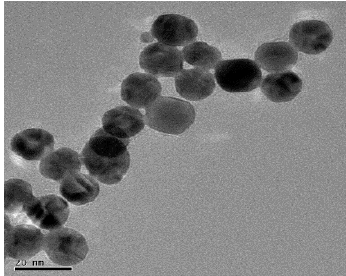
Figure 2. Ultraviolet–Visible Light (UV-Vis) scan images of gold nanoparticles (GNPs).